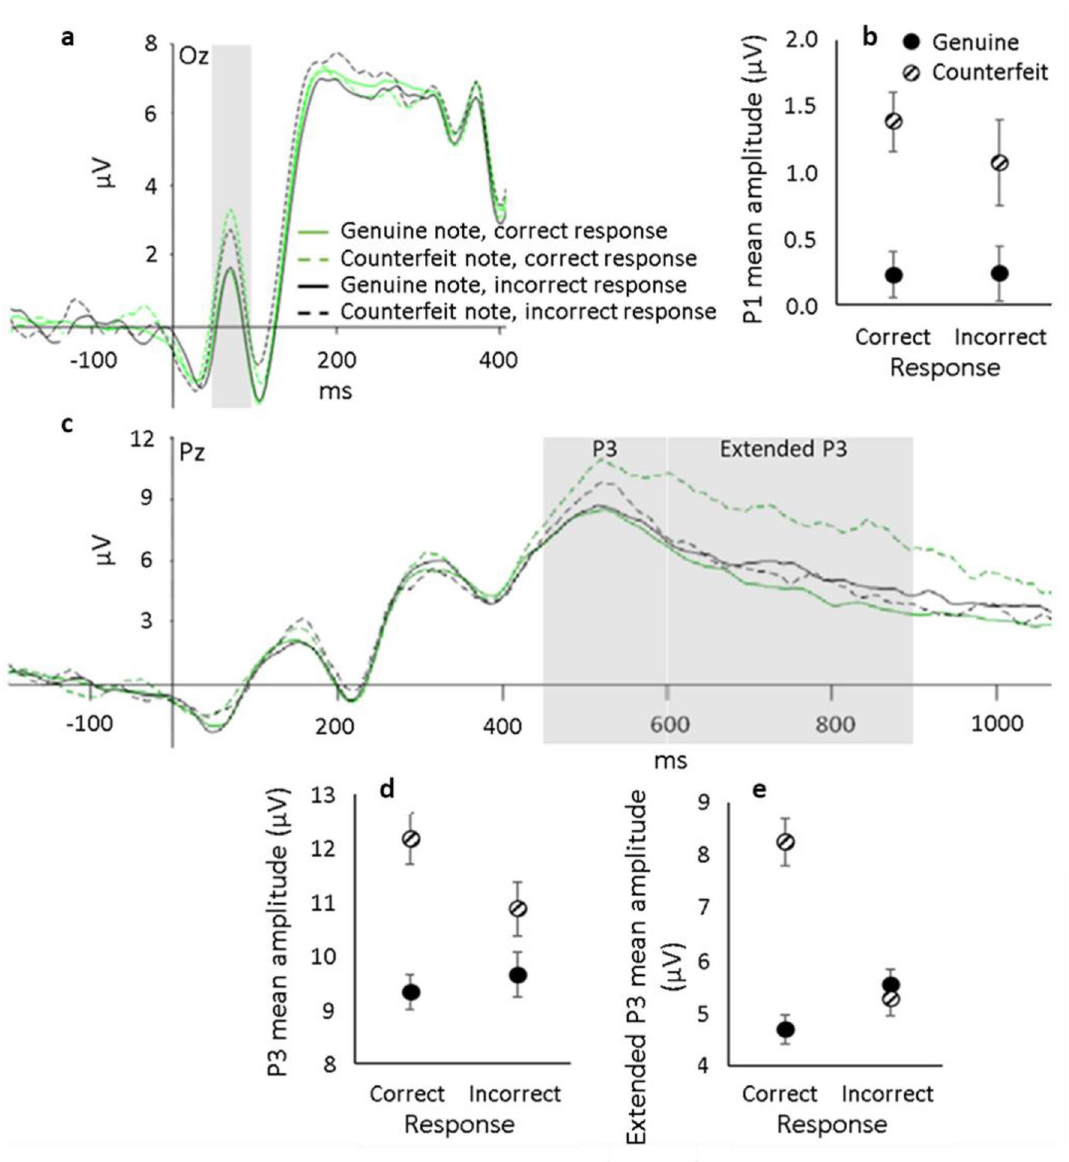
Figure 4. ERPs measured at two different electrode sites for each genuine (solid lines) and counterfeit (dashed lines) notes when the response was correct (green) and incorrect (black). Positive is plotted up. Shaded rectangle indicates the general time interval for each component. ( a ) ERPs obtained from electrode site Oz where effects on the P1 were observed. ( b ) Group mean amplitude at the P1 component plotted for each authenticity and the participants’ response. ( c ) Potentials obtained from electrode site Pz where effects on the P3 and extended P3 components (around 500 ms) were observed. Group mean amplitude at the P3 ( d ) and the extended P3 ( e ) components plotted for each authenticity and the participants’ response. Error bars represent ± 1 within-subject S.E of the mean 30